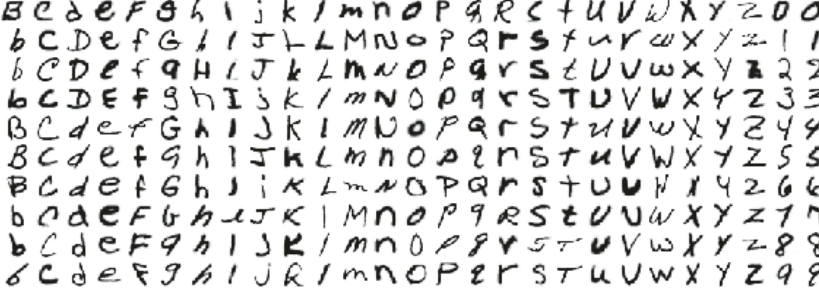
Figure 4: Samples of all letters and digits in the EMNIST